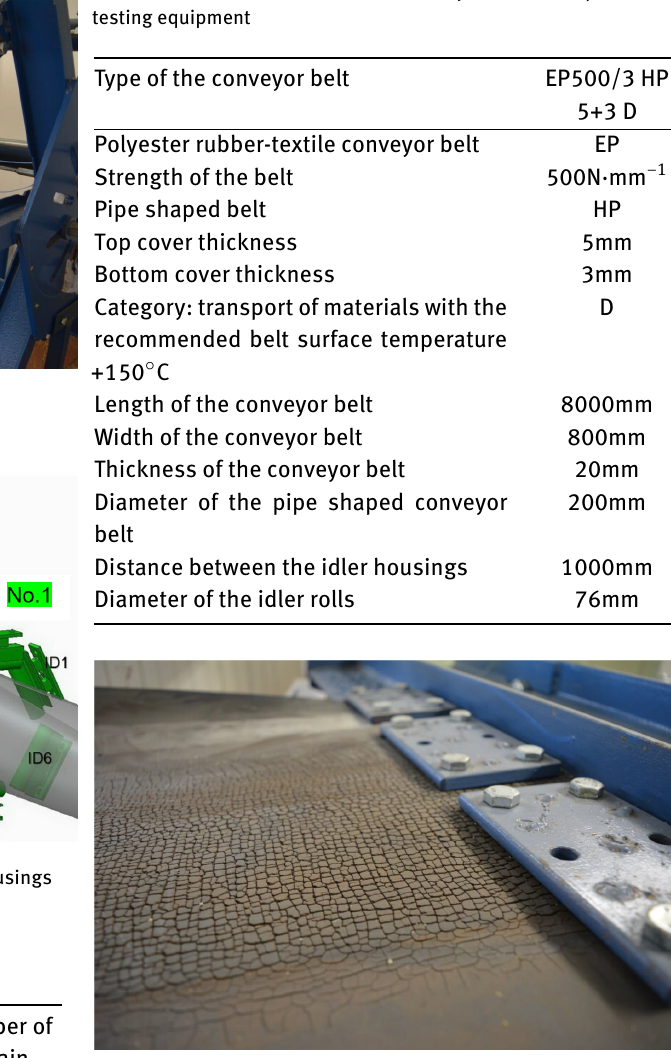
Table 3: Basic characteristics of the conveyor belt and experimental